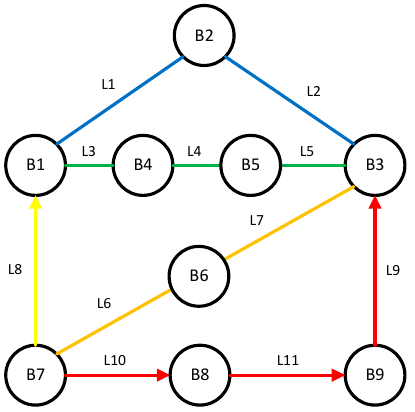
Figure 4. Network graph with protection zones indicated by different colors: blue (zone 1), green (zone 2), yellow (zone 3), orange (zone 4), and red (zone 5).